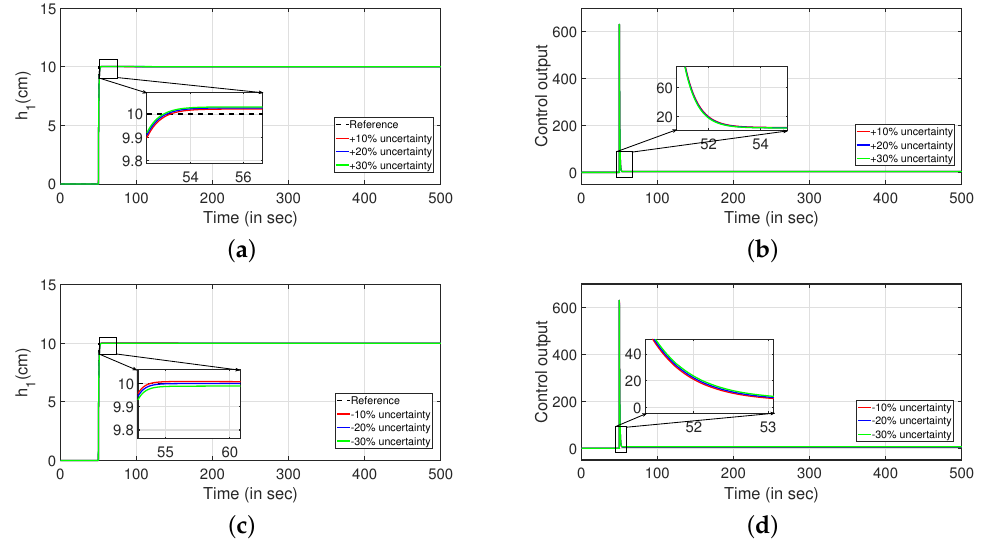
Figure 24. Reference tracking for PID controller with input uncertainties. ( a ) Level Variation in tank 1. ( b ) Level Variation in tank 2.